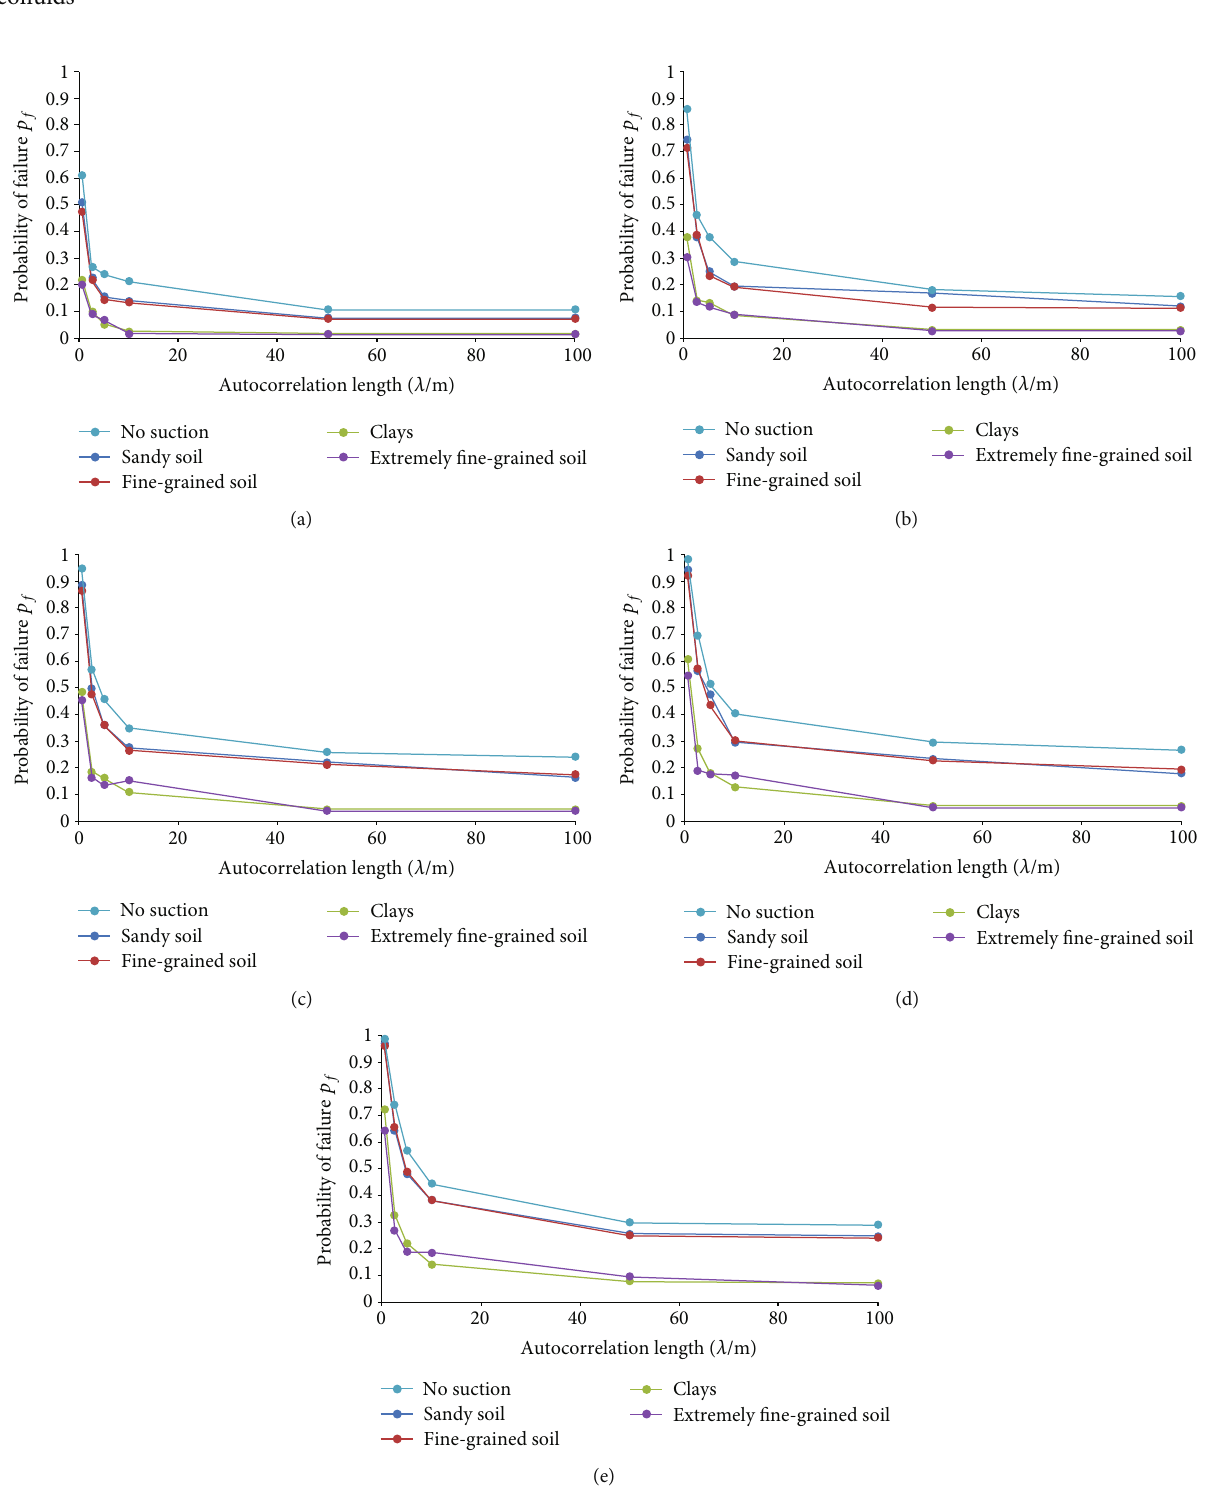
Figure 7: Probability of failure for di ff erent correlation coe ffi cients: (a) ρ = 0 : 5 , and (e) ρ